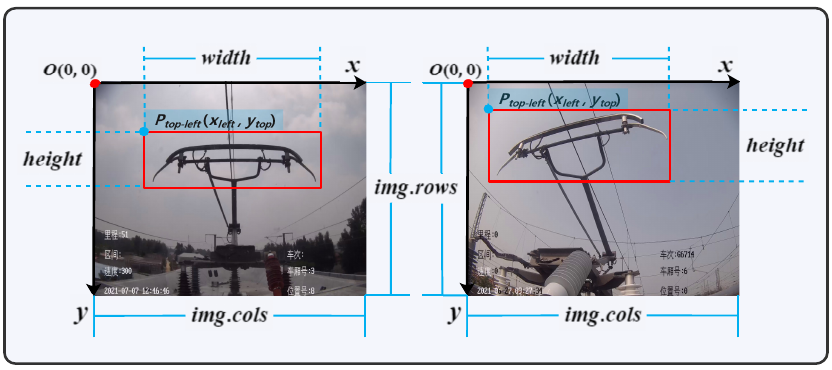
Figure 2. HSC footage of